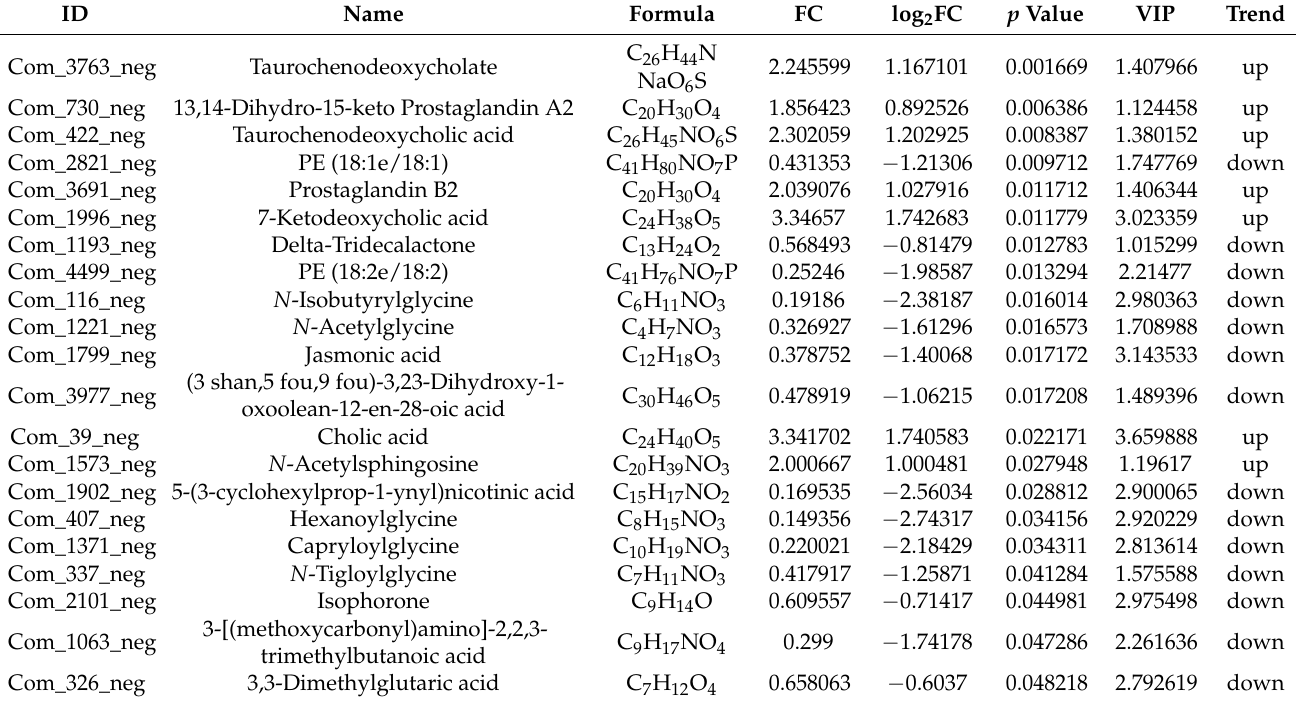
Table 2. Significant difference metabolites in negative mode.